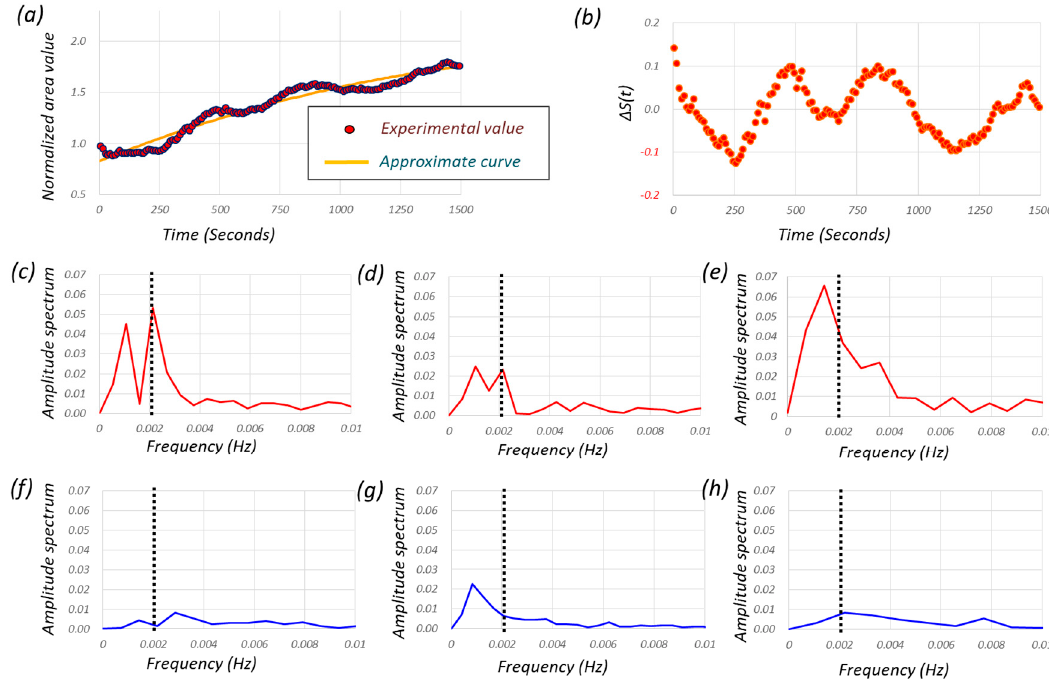
Figure 9. How to achieve frequency analysis, where ( a ) is the normalized area with respect to time where the approximate curve is shown by the line shown by red color, ( b ) the curve defined by S( t ) − S( t ) approximate curve , and ( c ) the frequency analysis. The frequency analysis, where ( c – e ) are under periodic hydrostatic pressure, and ( f – h ) are cultured under atmospheric pressure. Three of each of the six original data were carried out.